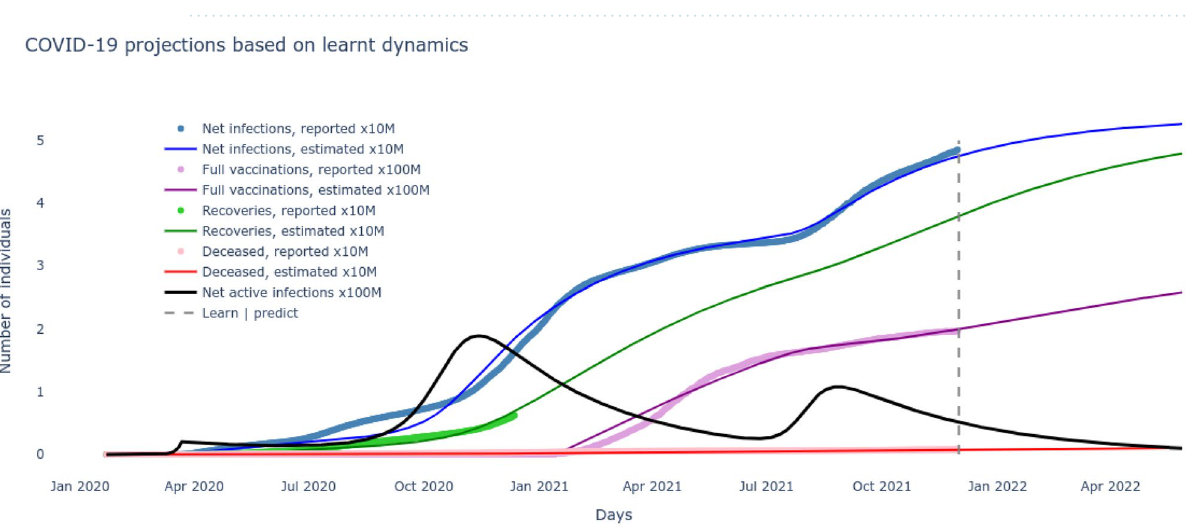
Figure 2. The SI 2 Q 2 R 2 VD system response with optimized parameters β , the reported COVID-19 data.